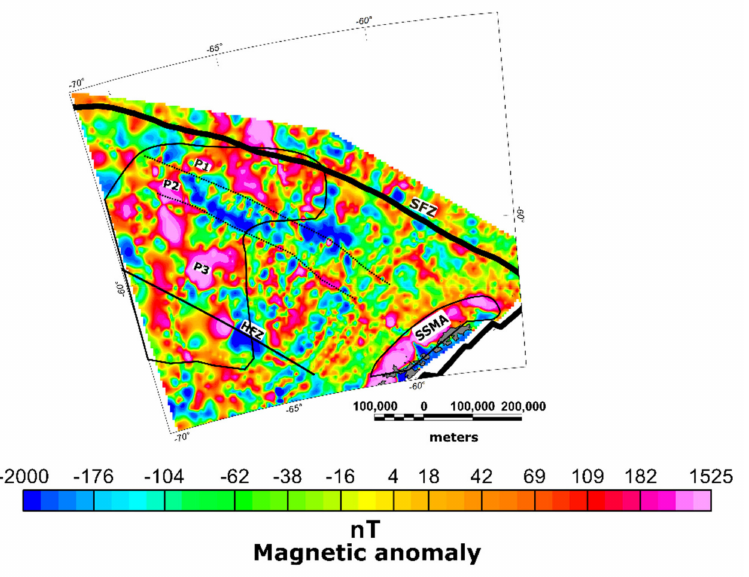
Figure 2. Magnetic anomaly map. Two solid curvilinear polygons encircle the areas where the largest amplitude of magnetic anomalies is located. Plate boundaries are represented by black solid thick lines. SSMA: South Shetlands magnetic anomaly. P1, P2, and P3 denote the three inactive plate segments of the Phoenix Ridge. Two black thin dotted lines separate P1, P2, and P3 zones. HFZ: Hero Fracture Zone. SFZ: Shackleton Fracture Zone. Both fracture zones are depicted with thick and thin black lines,